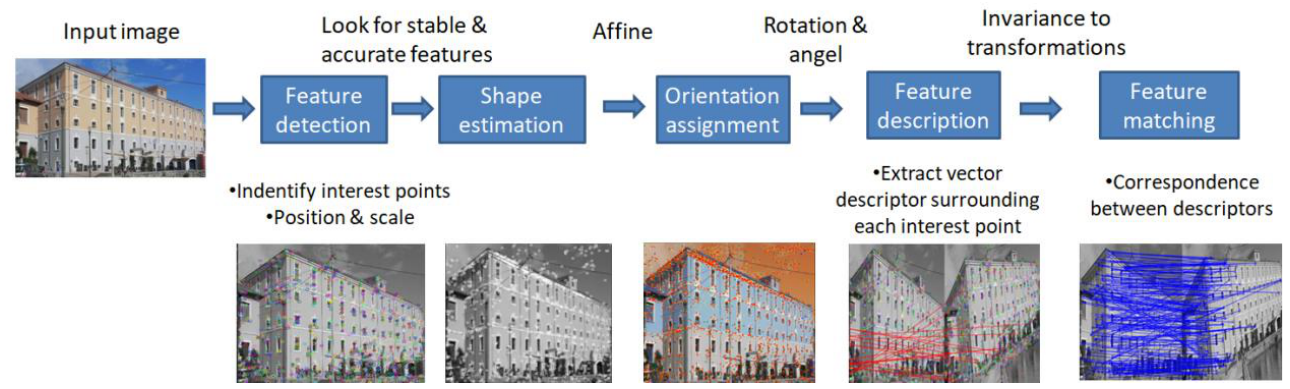
Figure 5. Feature detection and matching process.